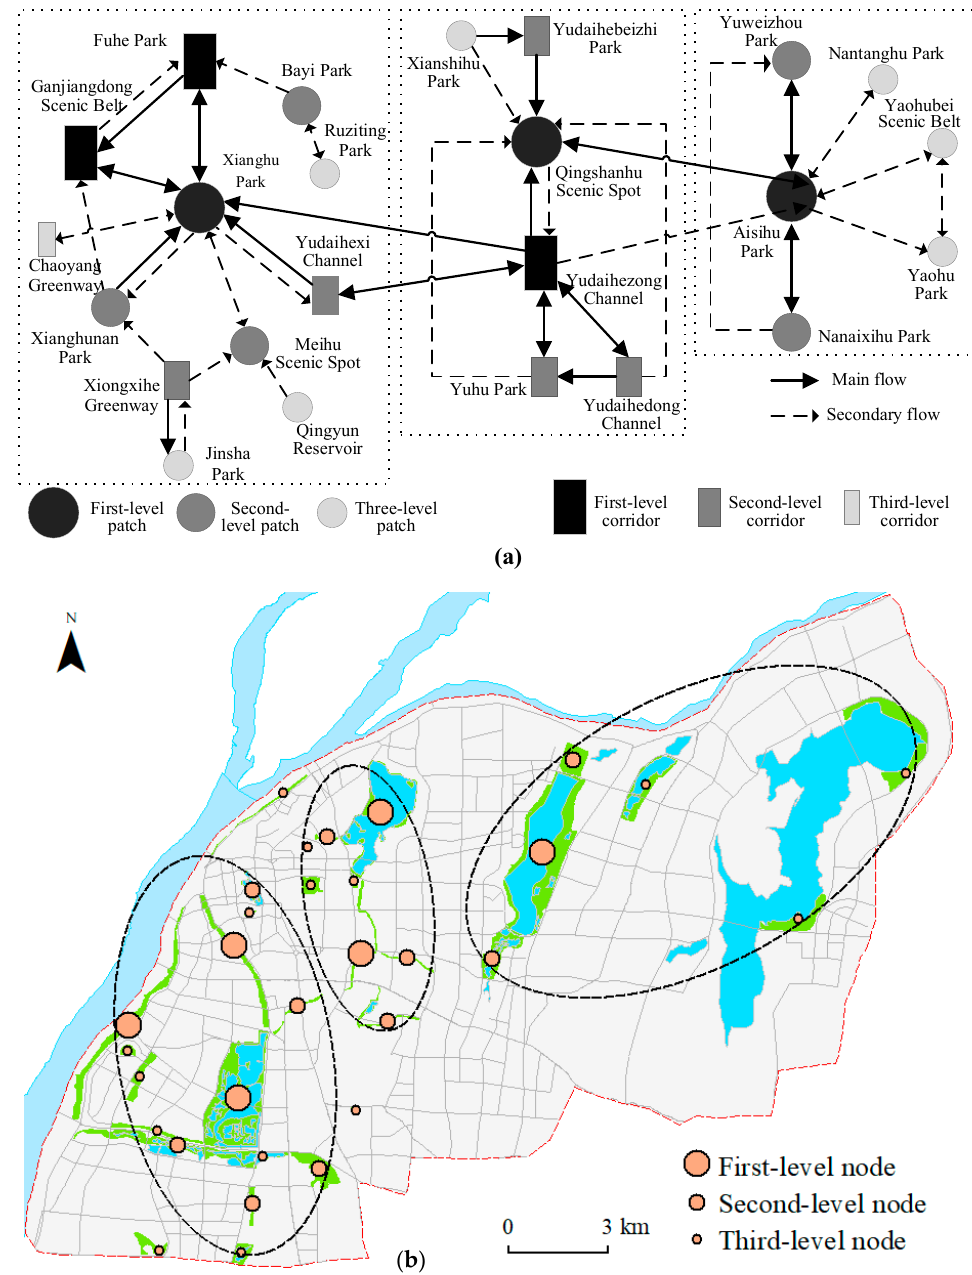
Figure 8. The division of the subnetworks in Nanchang: ( a ) the division of the flow network between the nodes; and ( b ) the location of the subnetworks. The dashed circle represents the approximate extent of the subnetwork.